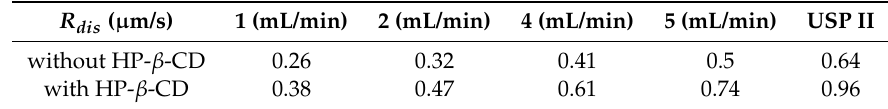
Figure 11. Detail of erosion effect on a film after complete release in the MFTD. The portion of the film exposed to the solvent is completely removed at the end of the experiment. Table 3. Disentanglement rate ( µ m/s) for release experiments in USP II apparatus and in MFTD at different flow